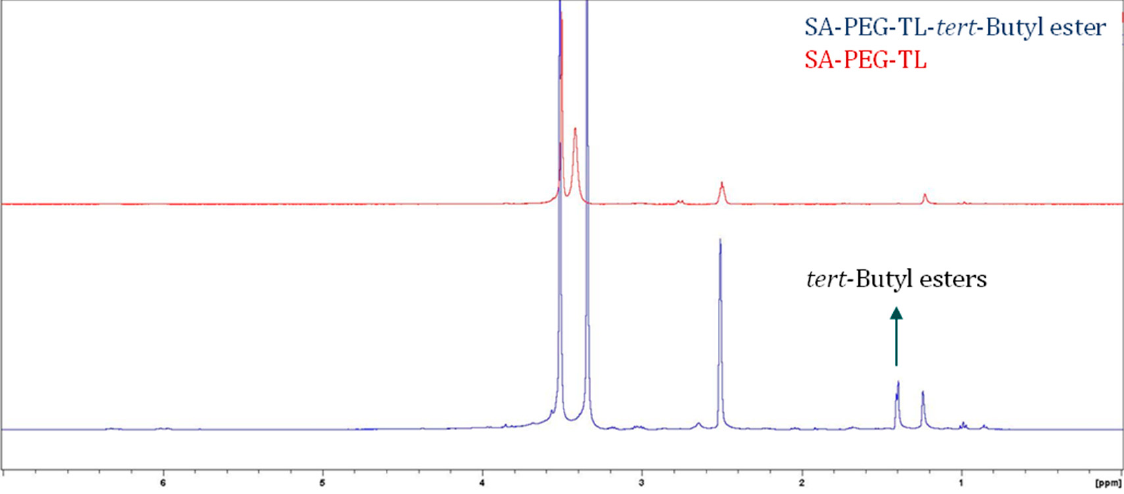
Figure 3. H-NMR spectroscopy. Tracings represent SA-PEG-TL with tert-Butyl esters protecting groups (blue) compared to the final conjugation product SA-PEG-TL (red). The H-NMR spectroscopy confirms that the tert-Butyl ester protecting groups were removed, thus revealing the carboxylic groups of the TL. Measurements were performed in duplicates.